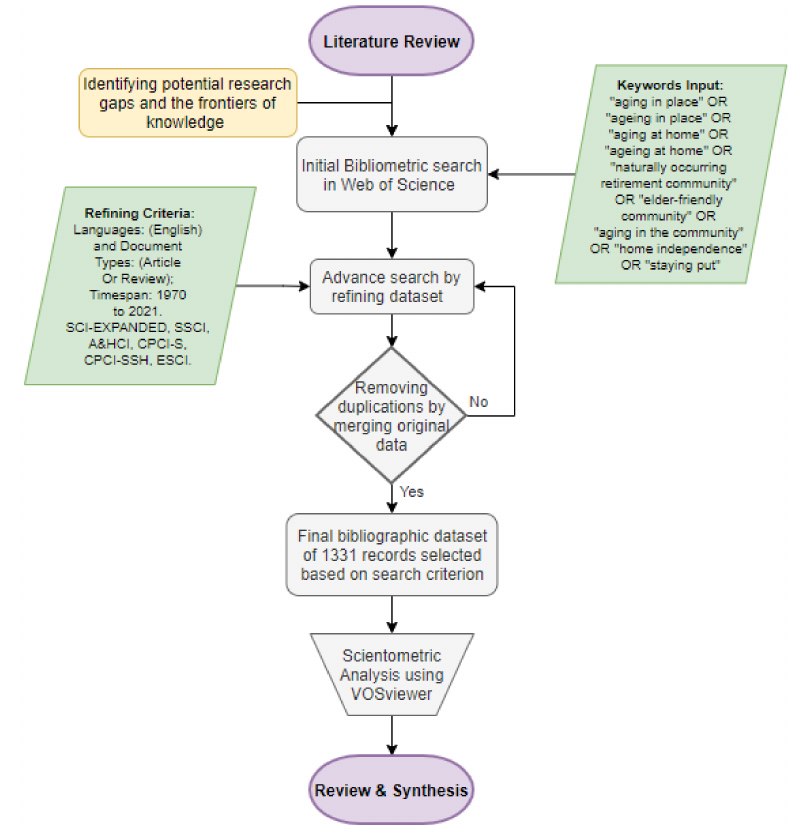
Figure 1. Methodology of the